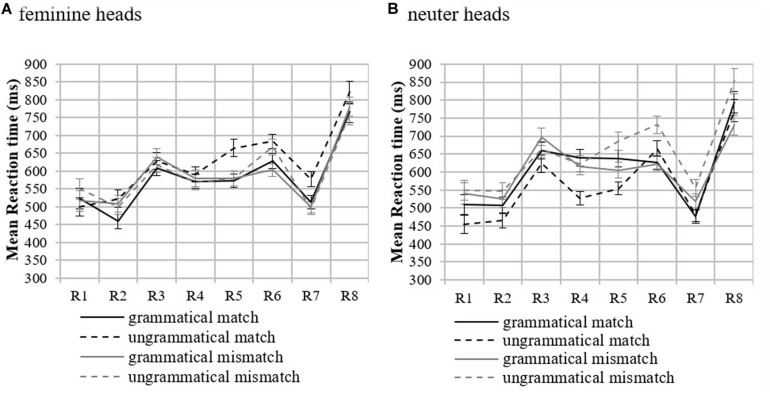
Mean reaction times by condition in feminine (A) and neuter (B) heads in Experiment 1. Error bars indicate the standard error of the mean across participants. R on the x-axis stands for Region. Region 3: Head, Region 4: Attractor, Region 5: Agreement target (adjectival predicate), Region 6: first post-critical region, Region 7: second post-critical region, and Region 8: sentence-final region.